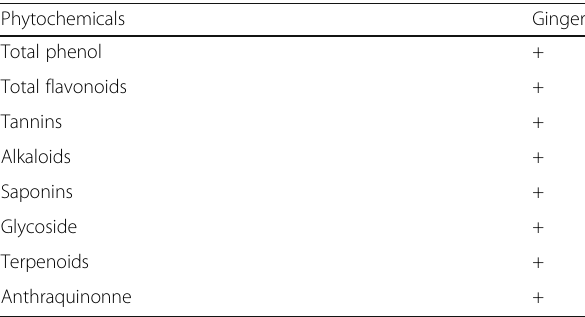
Table 1 Phytochemical compositions of methanol extract of Zingiber officinale